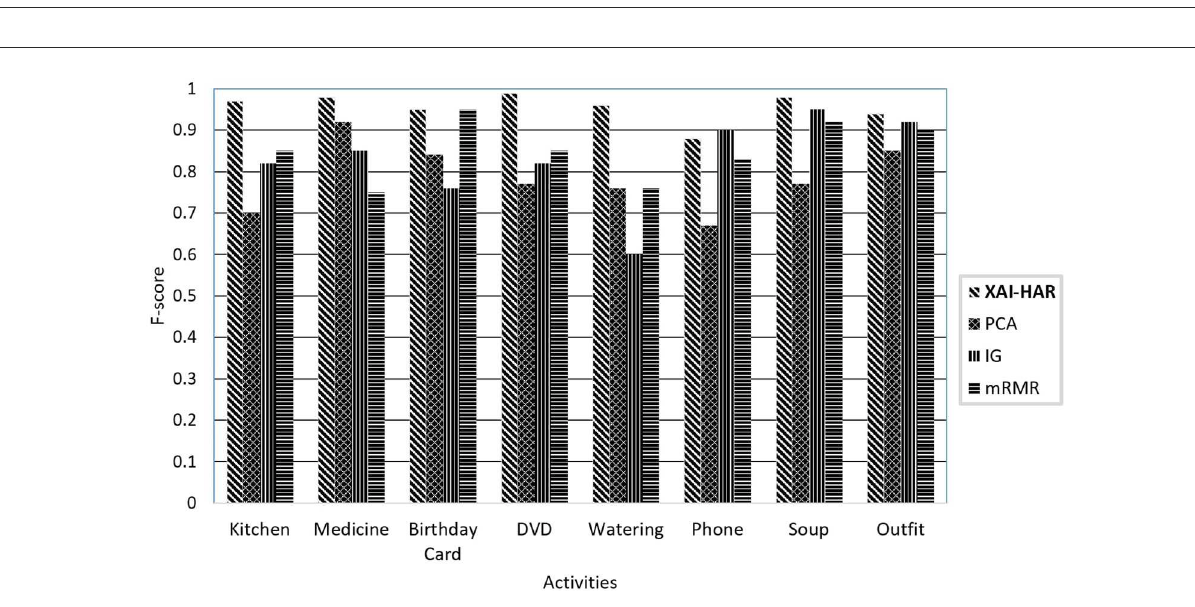
learning models on activities of healthy individuals and individuals with